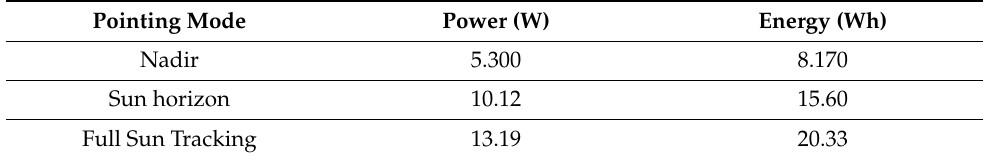
Table 3. Power and energy generated in different